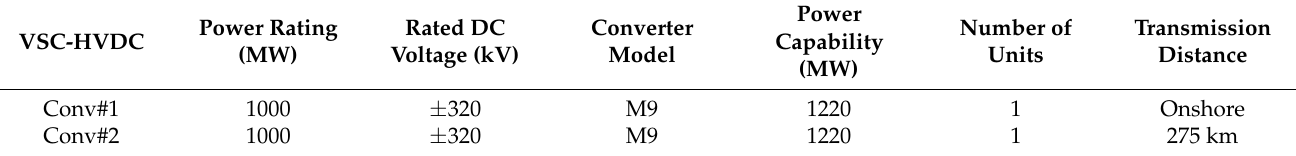
Table A12. VSC/HVDC-converters design for Architecture